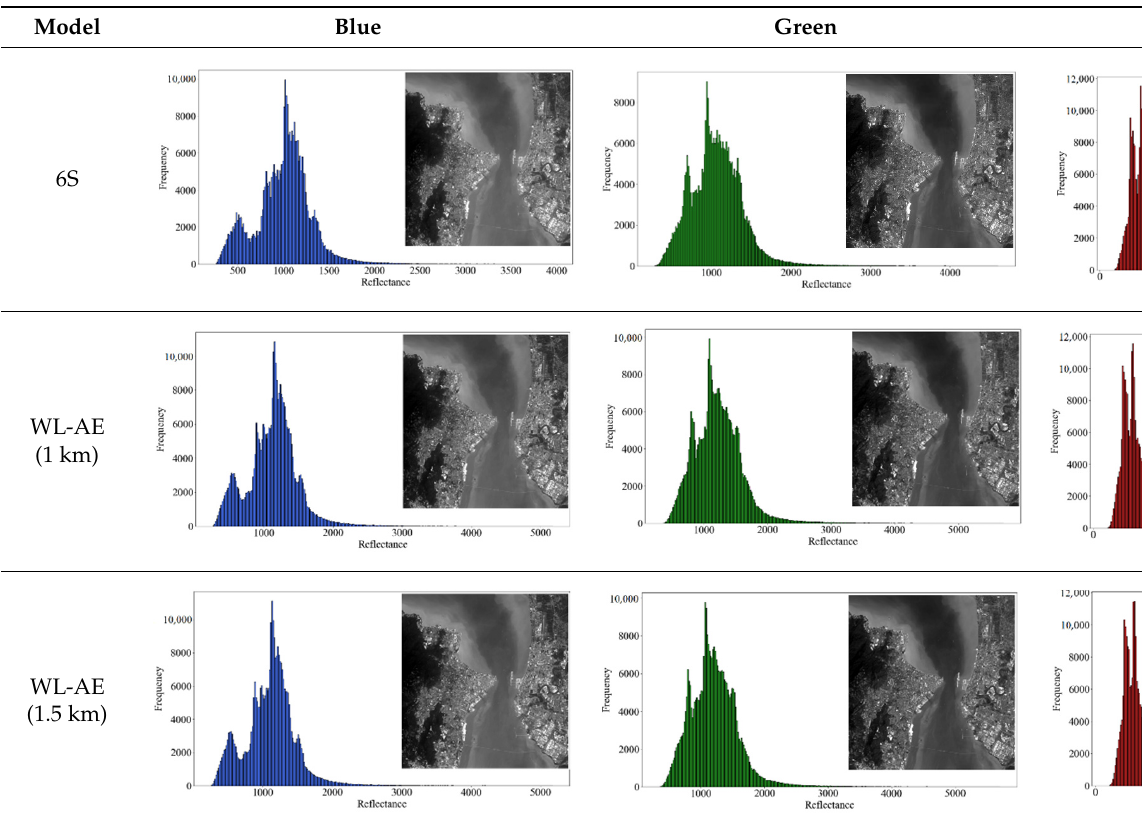
Table 1. Reflectance Histogram of Penang.